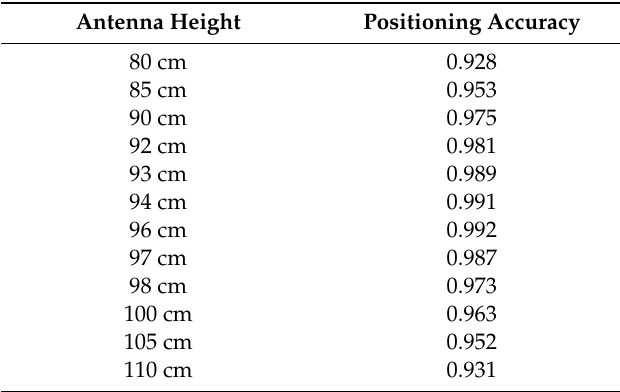
Table 5. Antenna